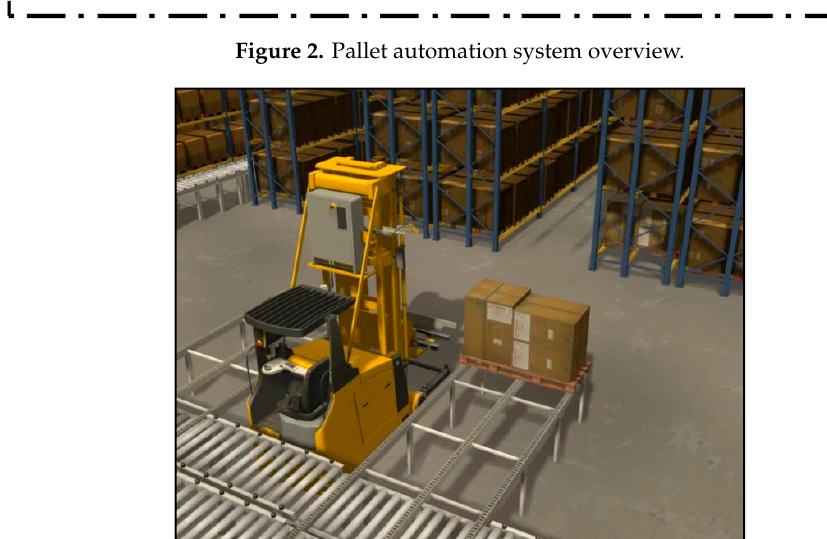
Figure 2. Pallet automation system overview.